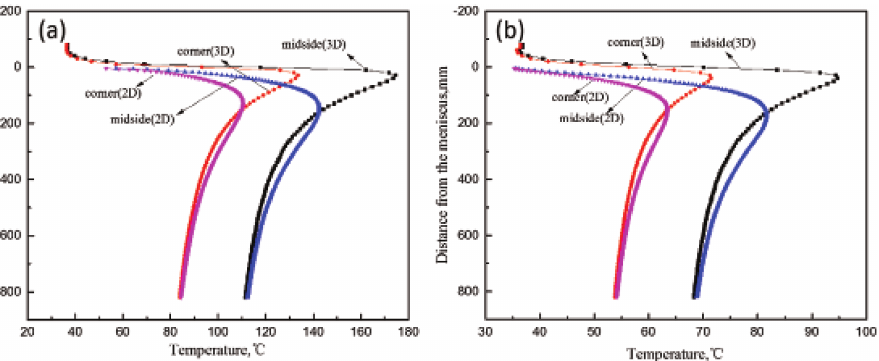
Figure 7: Distributions of longitudinal temperature of mold wall calculated using different models on (a) hot face and (b) cold face.